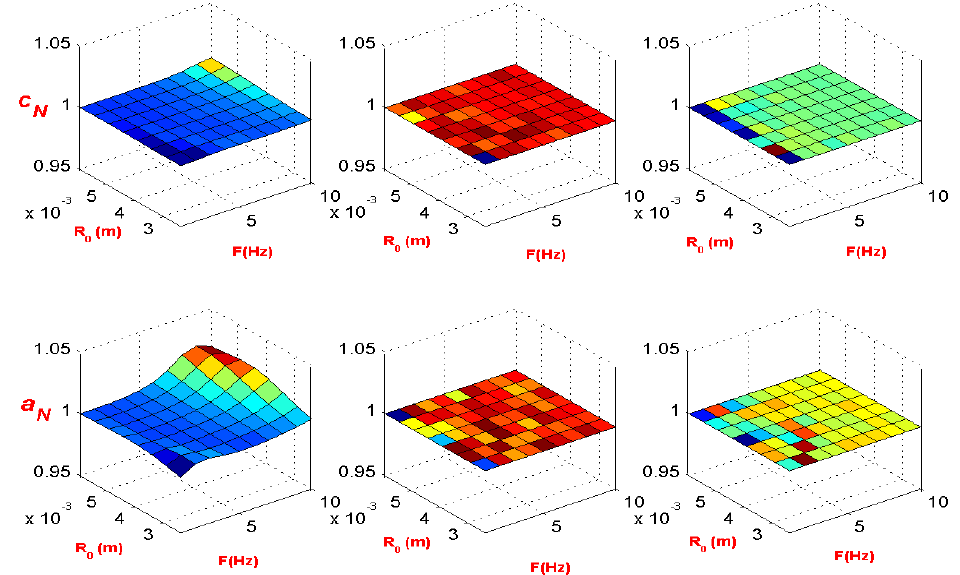
Fig. 6 Three dimensional view (see legend Fig.2) of frequency pattern of normalized phase velocity and normalized attenuation for various radius ( (cid:2174) (cid:2777) = (cid:2779). (cid:2781), (cid:2779).(cid:2786), (cid:2780). (cid:2781), (cid:2780).(cid:2786), (cid:2781). (cid:2781), (cid:2781).(cid:2786), (cid:2782). (cid:2781) (cid:2183)(cid:2196)(cid:2186) (cid:2782).(cid:2786) (cid:2195)(cid:2195)